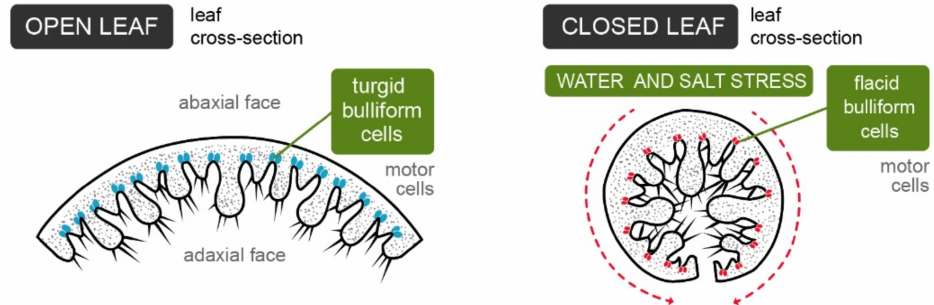
Figure 5. Ammophila arenaria ’s leaf-rolling mechanism. Source: